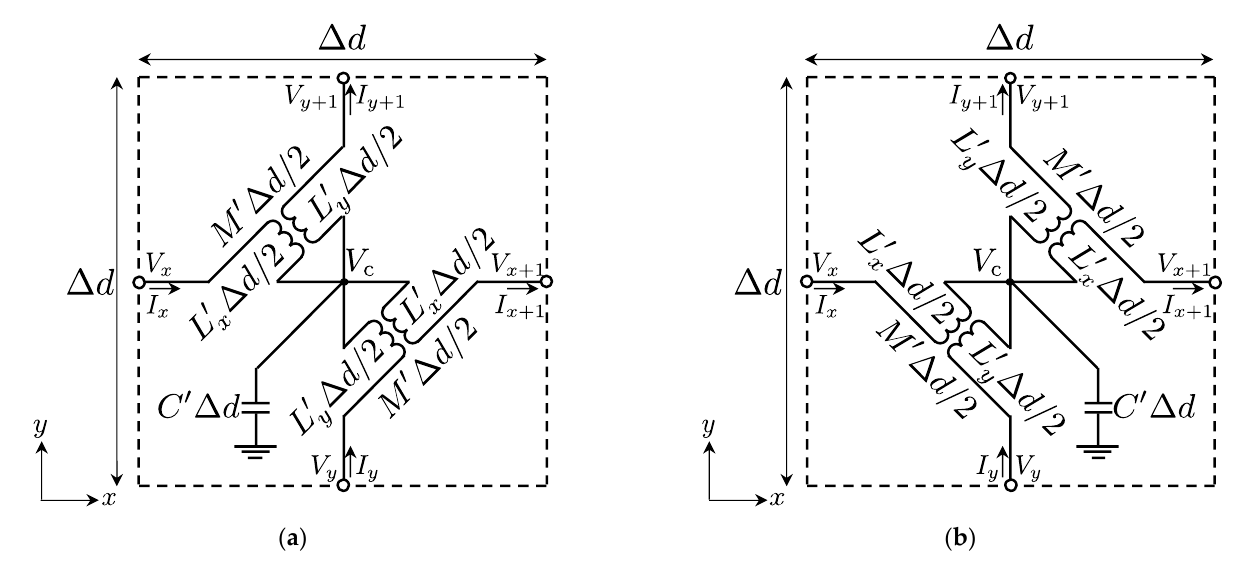
Figure 1. 2-D equivalent circuit models for full-tensor anisotropic acoustic metamaterials. ( a ) ρ xx < 0 case; ( b ) ρ xx > 0 case. Table 1. Circuit equations, 2-D Maxwell’s equations, and 2-D acoustic equations for full-tensor anisotropic electromagnetic or acoustic metamaterials.